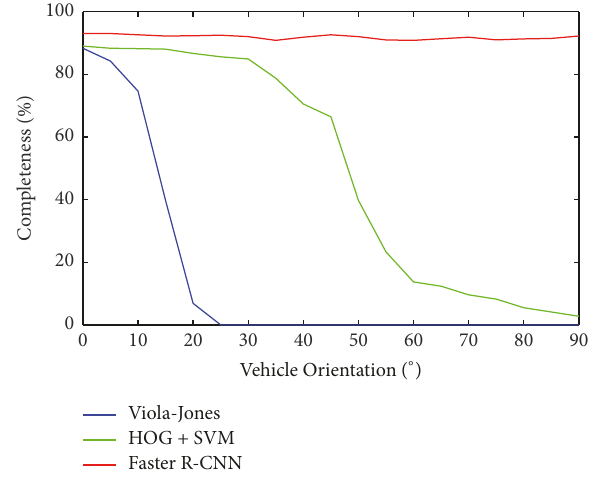
Figure 8: Sensitivity to vehicles’ in-plane